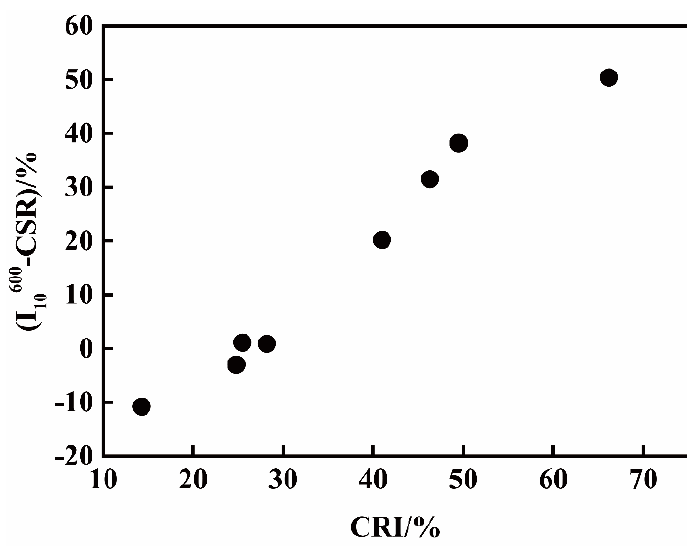
Figure 1. The comparison of I 10600 under T5 with CSR under T1 of cokes from single coals. Furthermore, the values of I 10600 under T5 minus CSR under T1 (I 10600 -CSR) vs. CRI are shown in Figure 2. It appears that the (I 10600 -CSR) values increase with the increase in CRI, and a line relation may exist, indicating that for cokes with high CRI from high volatile coals, a strong resistance capacity of strength deterioration appears at high temperatures.